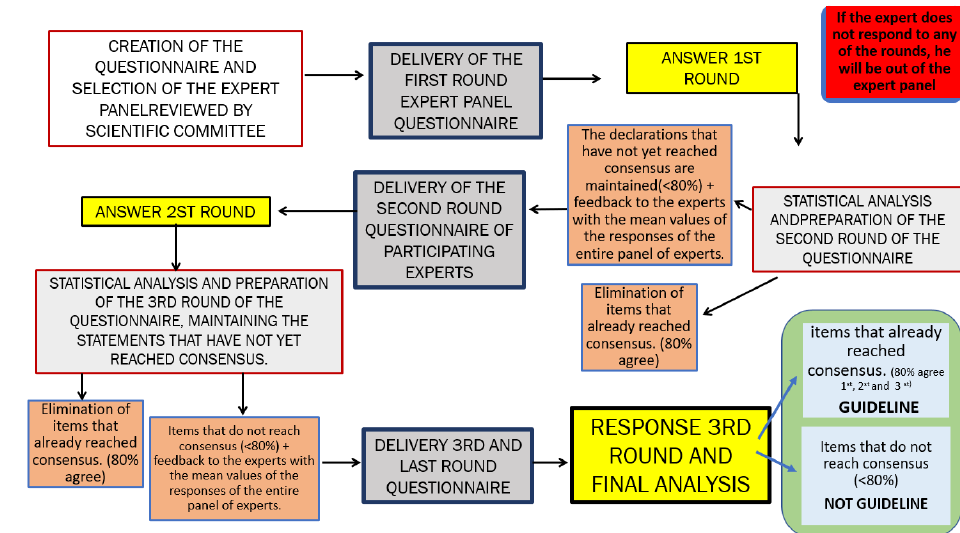
Figure 3. Delphi agreement diagram.